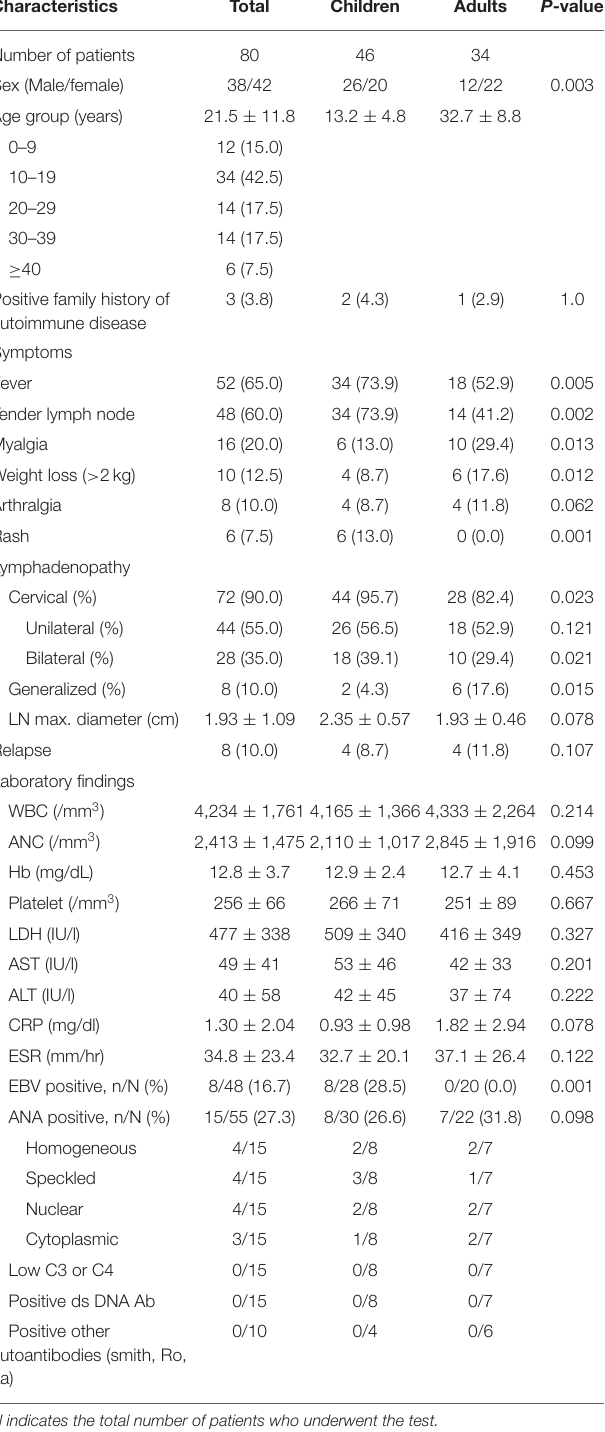
percentage. LN, lymph node; WBC, white blood cell; ANC, absolute neutrophil; Hb, hemoglobin; LDH, lactate dehydrogenase; AST, aspartate transaminase; ALT, alanine transaminase; CRP, C-reactive protein; ESR, erythrocyte sedimentation rate; EBV, Epstein-barr virus; ANA, anti-nuclear antibodies.